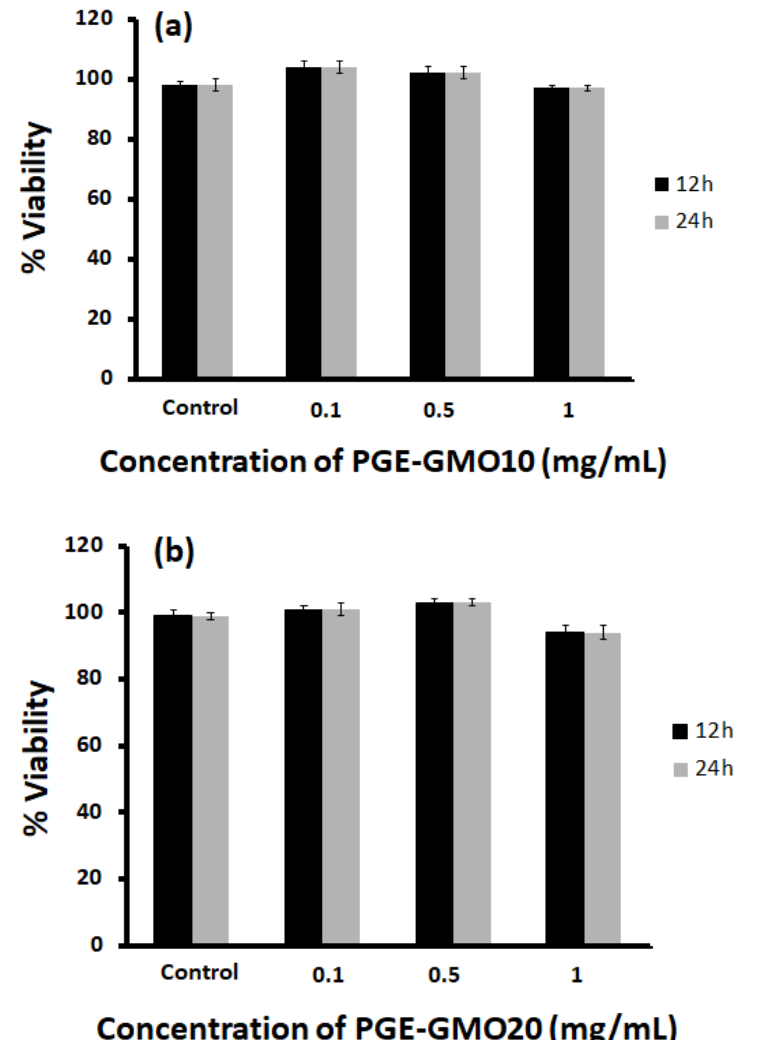
Figure 6. Cell viability of HaCaT cells after incubation with PEG-GMO10 ( a ) and PEG-GMO20 ( b ) formulations at different concentrations for 12 h and 24 h, respectively.